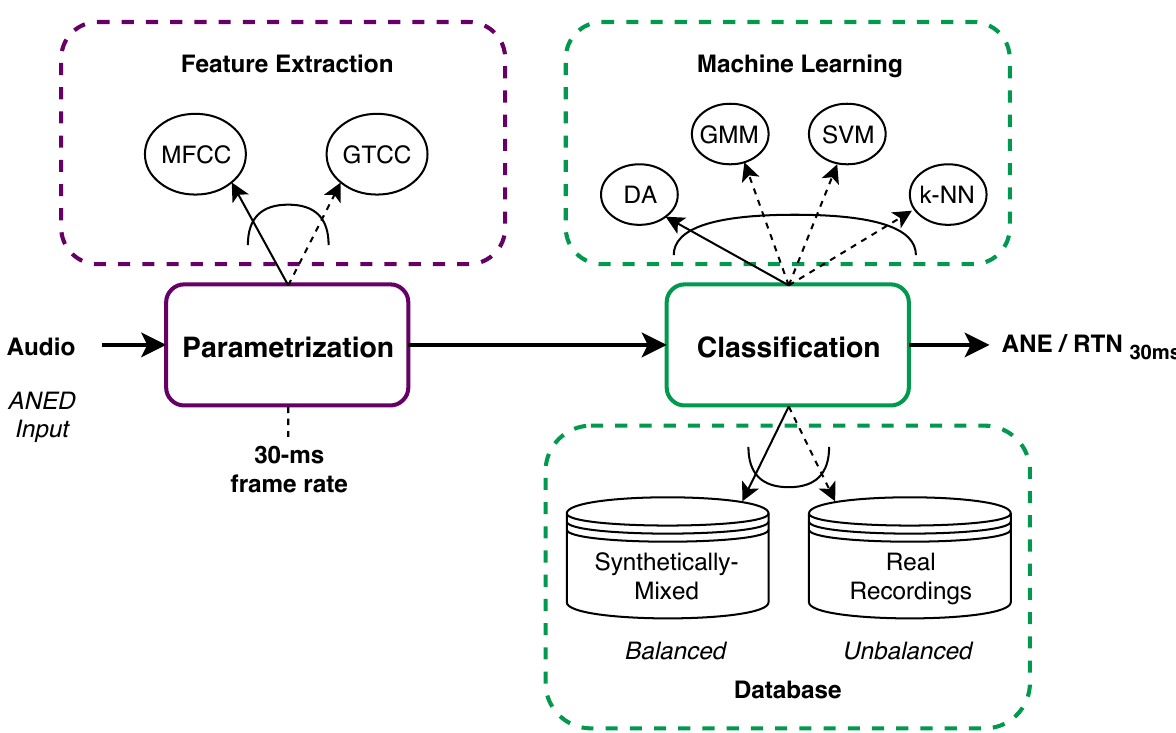
Figure 2: Block diagram of the frame-level decision phase of the ANED algorithm, composed of two main stages: parametrization of the input audio extracting the MFCC or GTCC at a 30-ms frame rate, and its binary classification as RTN or ANE. Four different classifiers (DA, GMM, SVM and k-NN) have been considered hitherto, which have been trained using both real-life or synthetically-mixed acoustic